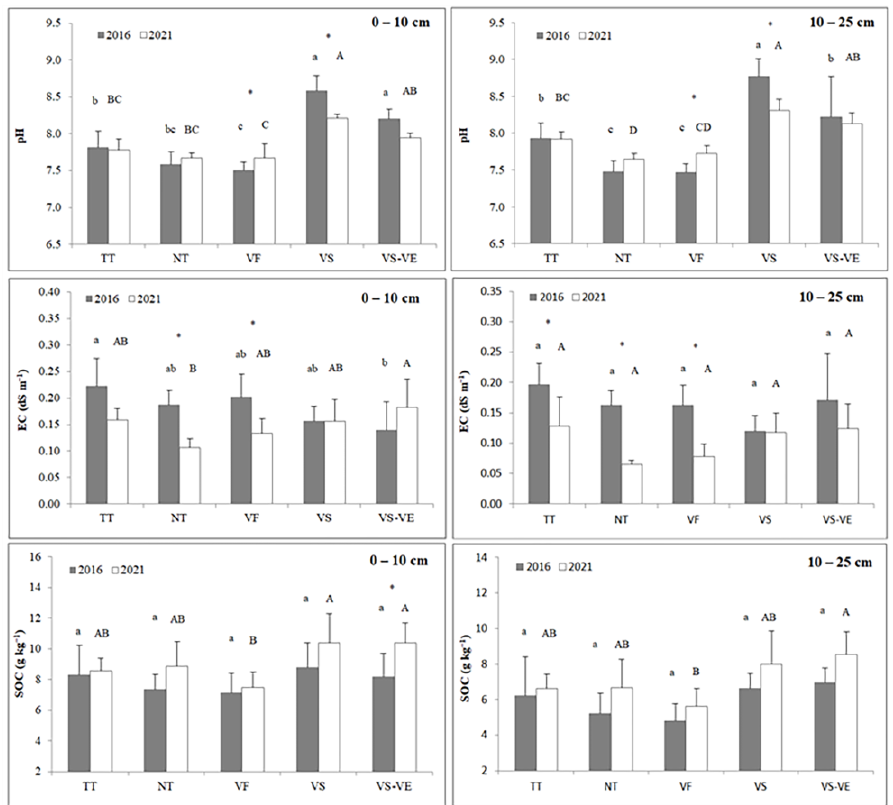
Figure 4. Average pH, electrical conductivity (EC) of the soil-saturation extract, and soil organic carbon (SOC) by the effect of different soil management strategies. TT, traditional tillage; NT, no tillage; VF, cover of V. faba ; VS, cover of V. sativa ; VS-VE, cover of V. sativa and V. ervilia . Bars are standard deviation. Different lowercase letters indicate significant differences at the beginning of study; different capital letters indicate significant differences at the end of the study; *, indicates significant differences between the two sampling periods (Tukey’s test, p < 0.05).